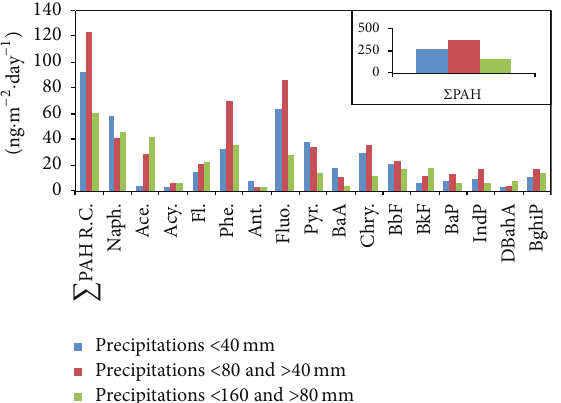
Figure 11: Average depositions of organic micropollutants for deposimeters D4 grouped according to precipitations. Total IPA concentrations are reported separately because of different scale.